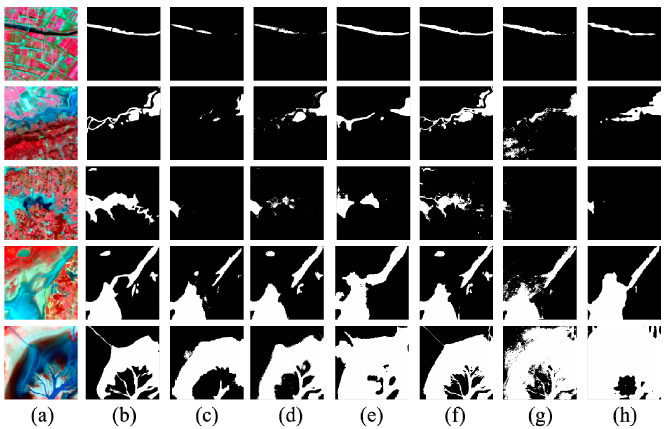
Figure 6. Examples of the recognition effect of different models which shows the high false negative (FN) of DenseNet. ( a ) False color composite remote sensing image, and water body identification result by ( b ) the ground truth, ( c ) the DenseNet, ( d ) the ResNet, ( e ) the VGG, ( f ) the SegNet, ( g ) the DeepLab v3+ and ( h ) the NDWI models. White color indicates the identified water bodies.